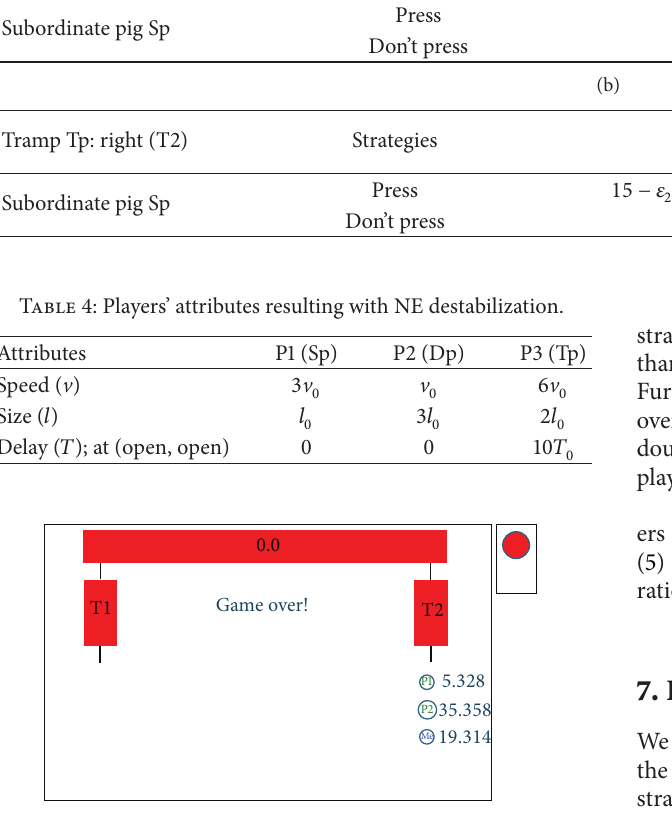
Figure 6: Rational Pigs Extended outcomes for ( Press, Don’t press, R )